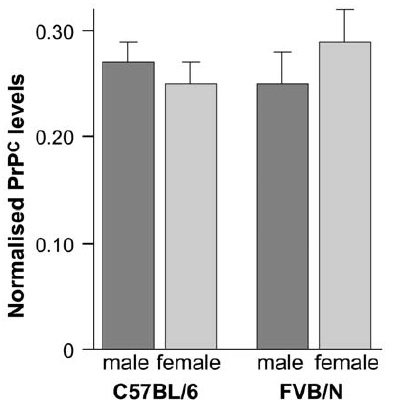
Figure 2. PrP C levels for male and female C57BL/6 and FVB/N mice. PrP C levels (ug/ml) were determined in triplicate using 10% (weight/volume) brain homogenate for male (n=3) and female (n=3) mice of each strain in a PrP specific ELISA. Data are shown normalised by total protein content (ug/ml and 6 1000) as determined by a BCA assay (mean 6 standard deviation). No significant differences were seen between males and females or between strains.